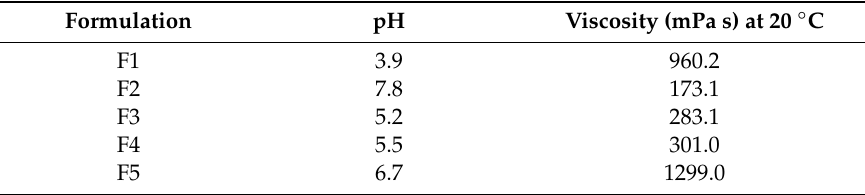
Table 3. pH and viscosity of rapamycin